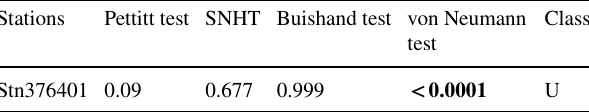
Bold number represents p < 0.05 indicating inhomogeneity in the cor- responding time series at a 5%